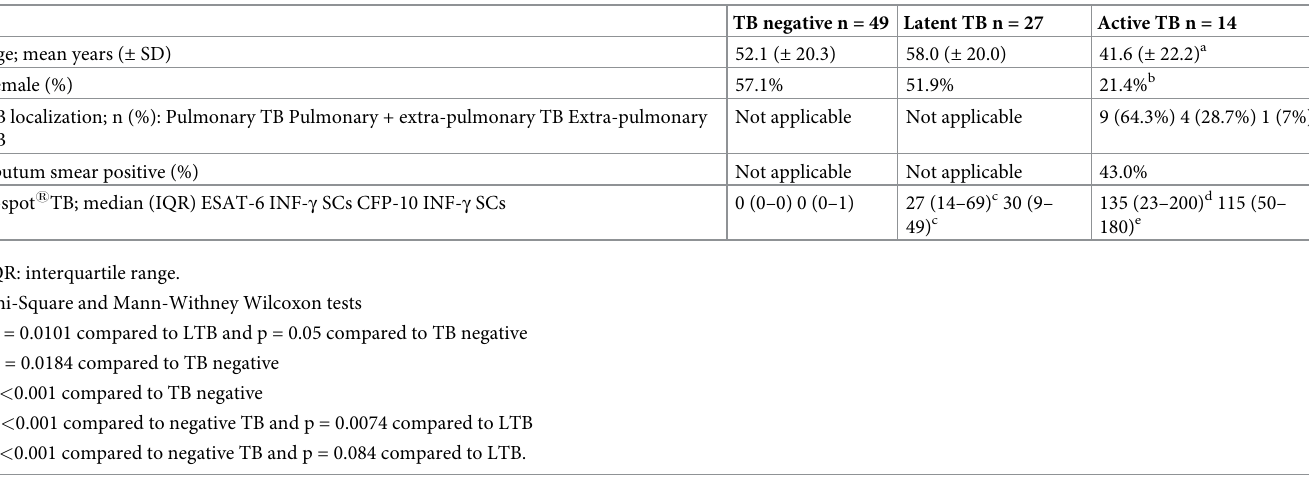
Table 1. Subjects